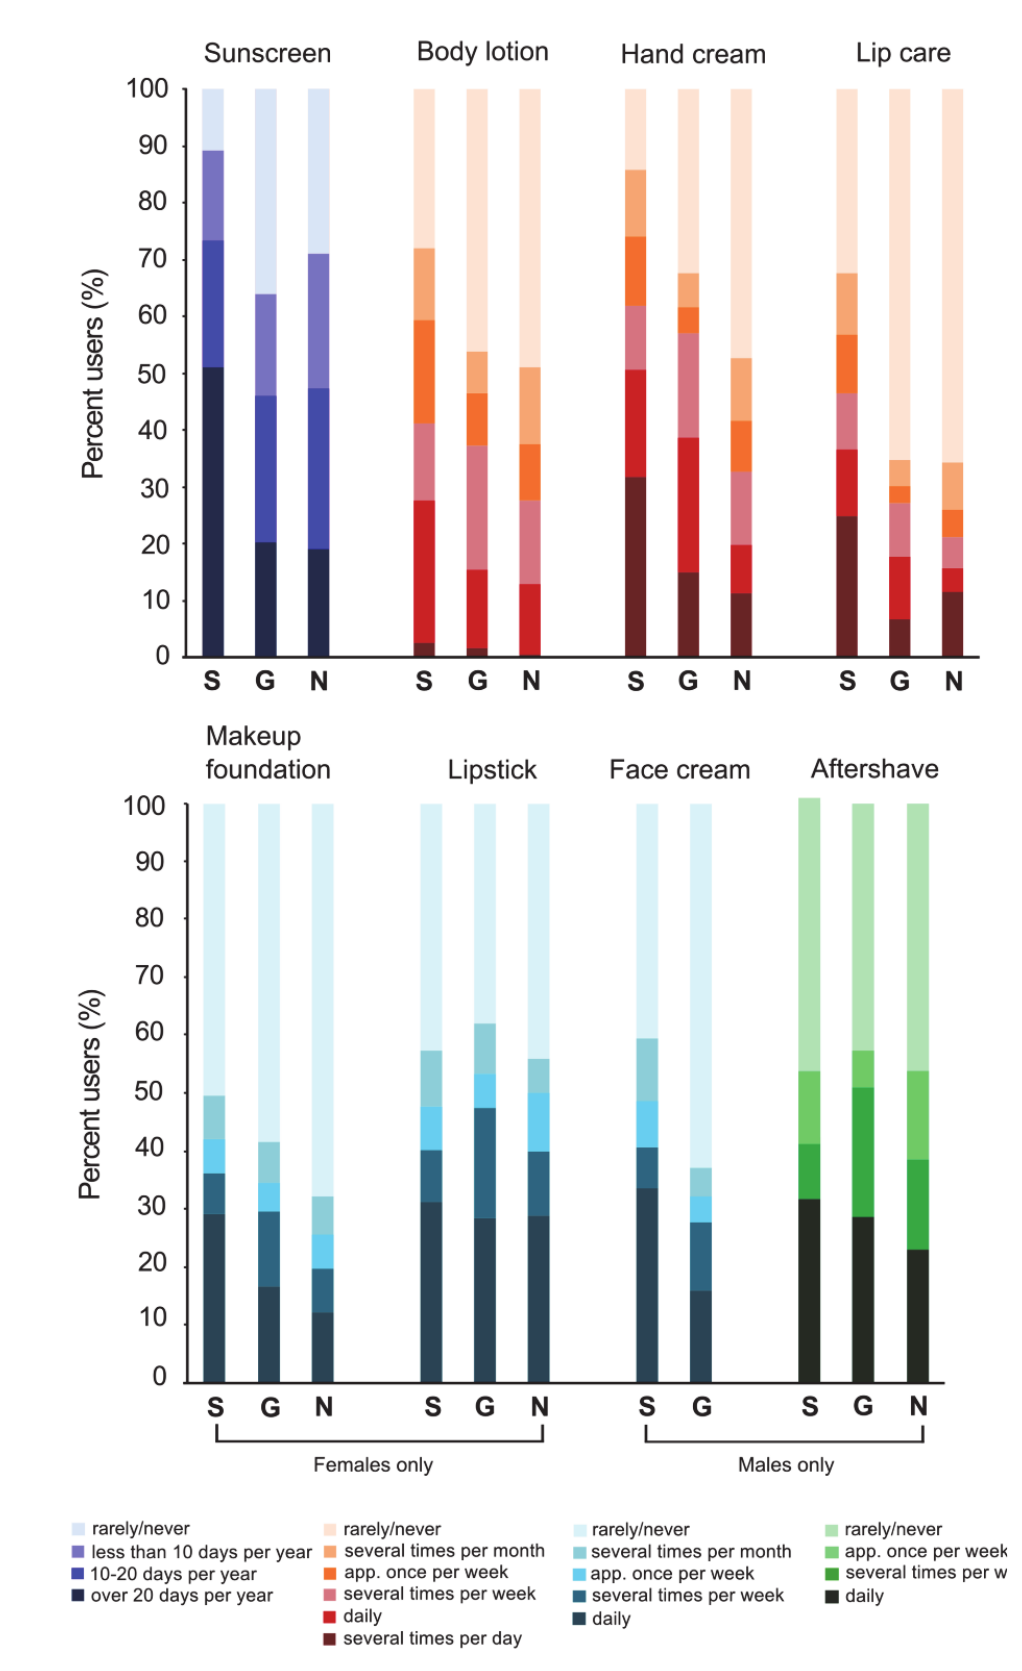
Figure 4. Comparison of PCP use amongst German-speaking Switzerland (S), Germany (G), and the Netherlands